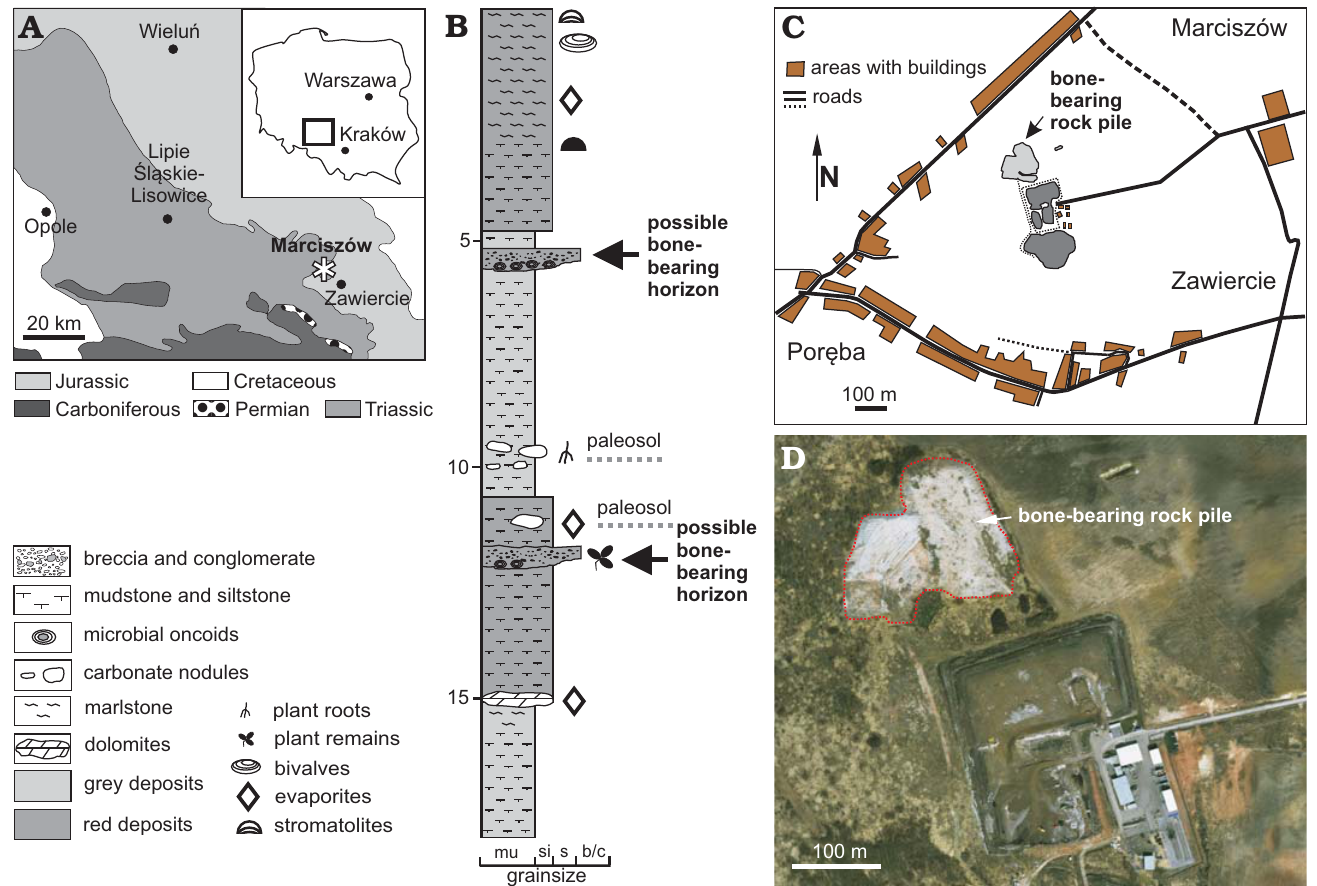
Fig. 1. A . Geological map of the Silesia showing location of the Marciszów site (asterisk), where the Smok sp. fossil remains were discovered (modified from Nied ź wiedzki et al. 2014). B . The schematic section of the Marciszów site; arrows indicate two horizons suspected as being provenance of the bones; (modified from Budziszewska-Karwowska et al. 2010). C , D . Maps ( C , simplified plan of Marciszów; D , satellite map of the area from Google Earth ® ) showing position of the bone-bearing rock pile. Abbreviations: b/c, breccia and conglomerate; mu, mudstone; s, sandstone; si,